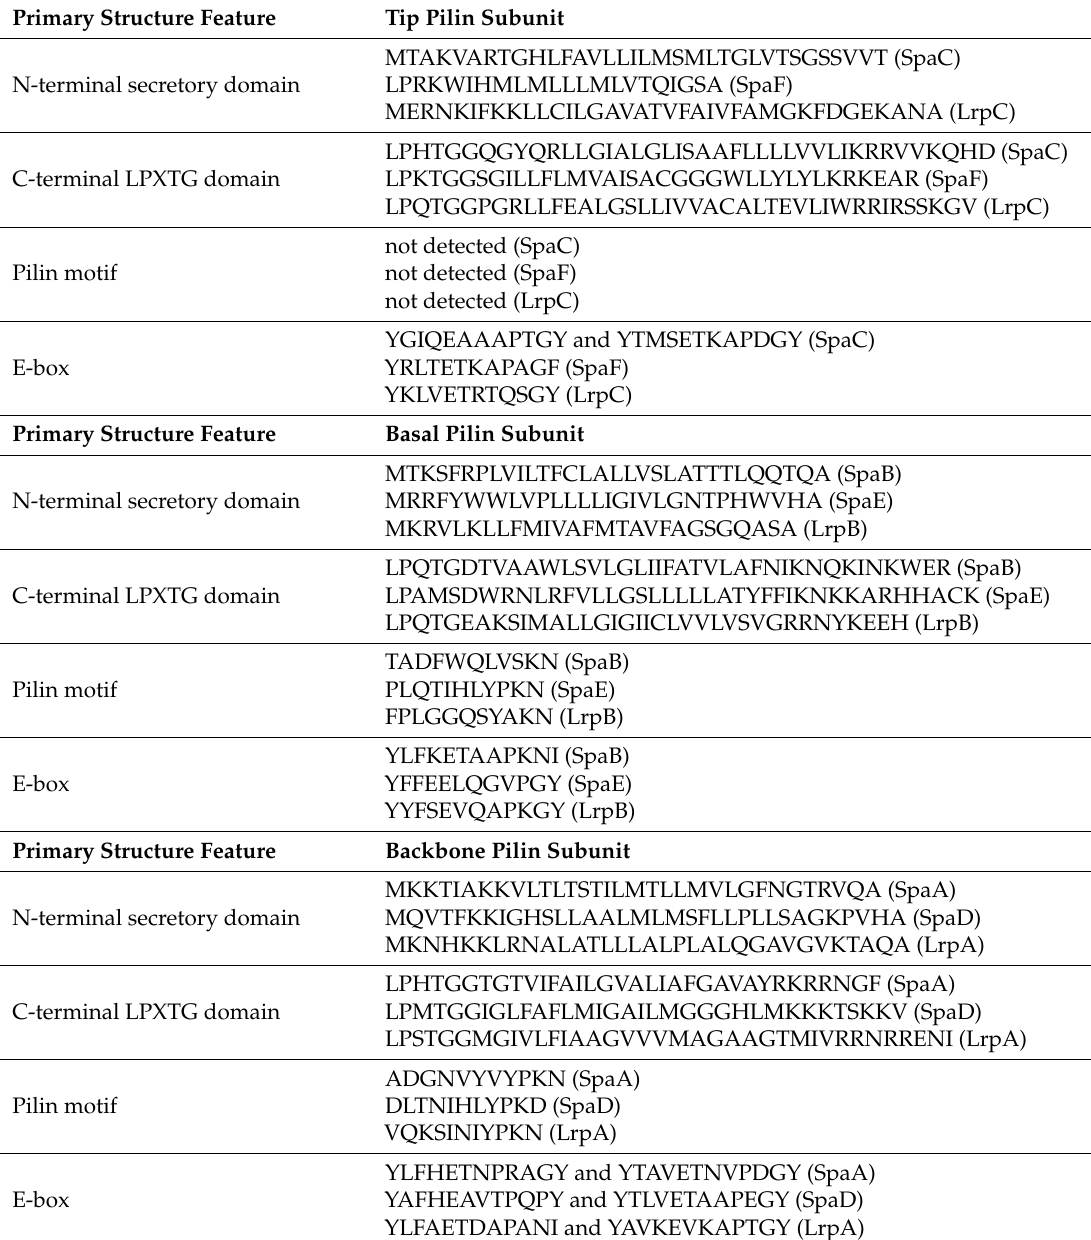
Table 1. Overview of conserved amino acid sequence motifs and domains in the lactobacillar SpaCBA, SpaFED, and LrpCBA pilin subunits.